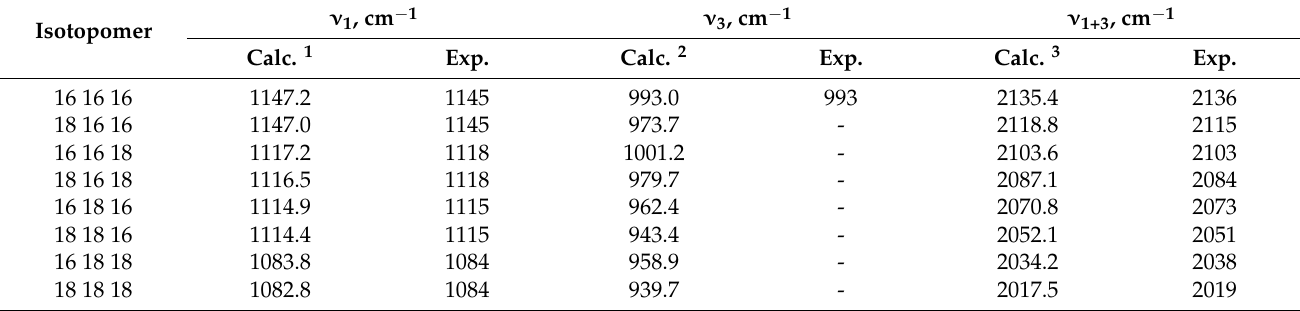
Table 2. Experimental and calculated frequencies of different isotopomers of monodentate ozone complex with cluster TiO 2 . ν 1 , cm − 1 ν 3 , cm − 1 ν 1+3 , cm − 1 Isotopomer Calc. 1 Exp. Calc. 2 Exp. Calc. 3